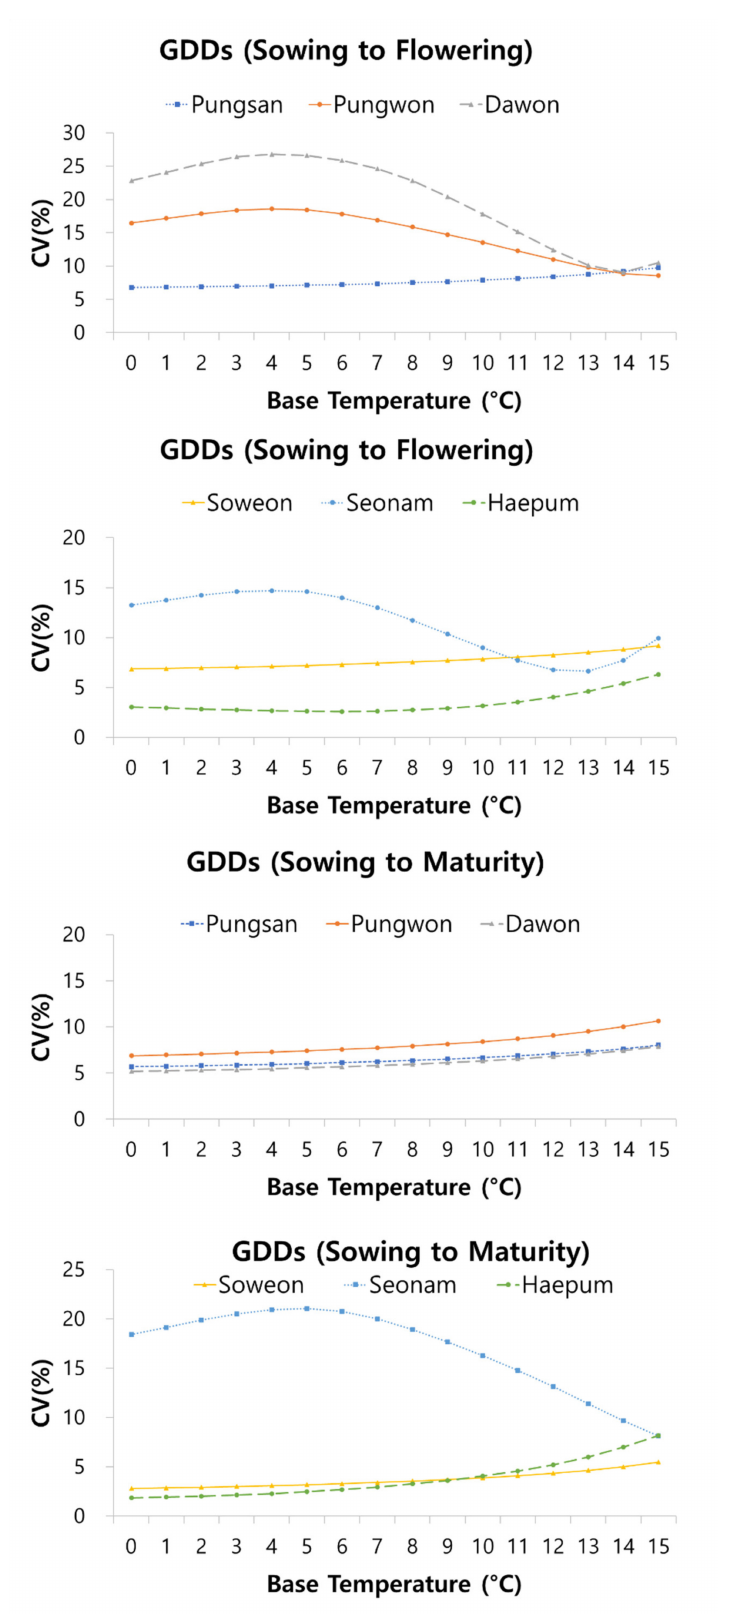
Figure 3. Coefficient variation (CV) of base temperatures used in a growing degree day formula for estimating developmental time from sowing to flowering and sowing to maturity of six soybean sprout